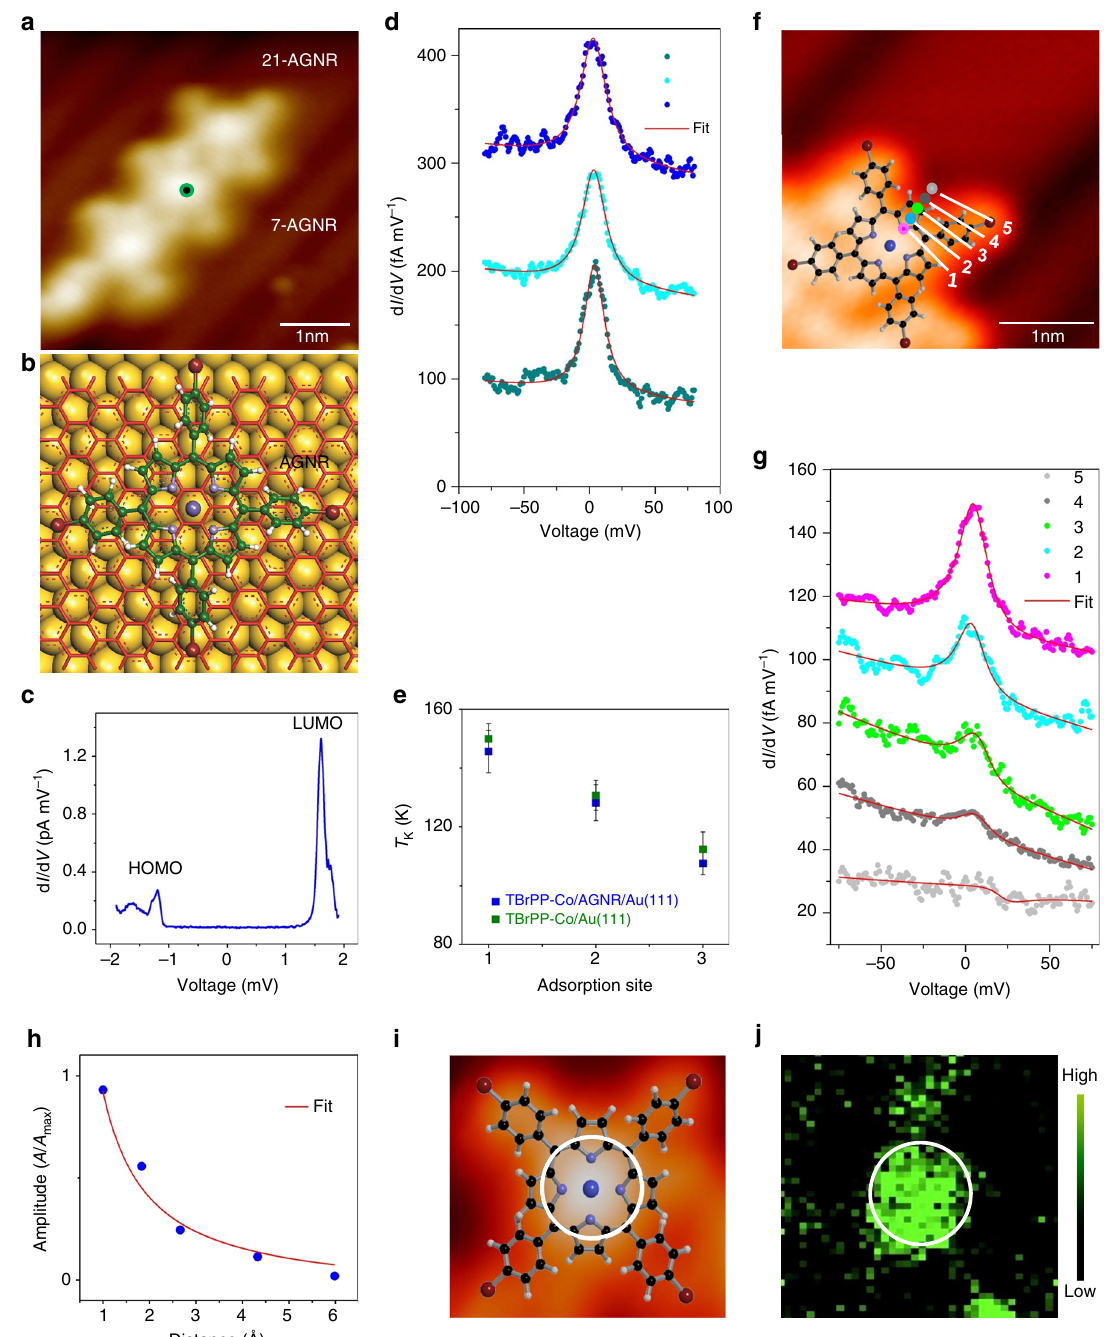
Fig. 3 Properties of TBrPP-Co/AGNR/Au(111). a STM image of TBrPP-Co on AGNR (4.5 × 4.5 nm 2 , I t = 3 × 10 − 12 A, V t = 1 V). b Adsorption site of TBrPP-Co on AGNR. c d I /d V – V spectroscopy of TBrPP-Co on AGNR/Au(111) shows a fl at bottom at the HOMO – LUMO gap (tip set-point: I 0 = 1.0 × 10 − 11 A, V 0 = 1.99 V). d High-resolution d I /d V spectra of TBrPP-Co on AGNR/Au(111) exhibit Kondo peaks with three different T K values ( q = 247, 250 and 250 for 1, 2 and 3, respectively. Tip set-point: I 0 = 1.0 × 10 − 11 A, V 0 = 0.2 V. Spectra are vertically offset by 100 fA/mV for clarity). e T K as functions of adsorption site 1, 2 and 3 (Fig. 2d – f) for TBrPP-Co on AGNR/Au(111) ( green ) and on Au(111) ( blue ). Error bars are determined from the standard deviations of the Kondo fi ts. f An STM image of TBrPP-Co at the end of a molecular cluster on AGNR (4.6 × 3.3 nm 2 , I t = 1 × 10 − 11 A, V t = 0.2 V). g A sequence of d I /d V spectra taken at the locations of coloured dots labelled 1 – 5 in f show decreasing Kondo amplitudes as the tip moves away from the molecule centre (tip set-point: I 0 = 1.0 × 10 − 11 A, V = 0.2 V. Spectra are vertically offset by 20 fA/mV for clarity). h The normalized Kondo amplitude ( A / A 0 max ) as a function of distance r from the molecule centre show r 1 dependence. i A zoom in STM image of a TBrPP-Co molecule (2.0 × 1.9 nm 2 , I t = 1 × 10 − 11 A, V t = 0.2 V) and corresponding d I /d V Kondo map j acquired at 7 mV energy [tip set-point: I 0 = 1.0 × 10 − 11 A, V 0 = 0.2 V). The central part of the molecule is circled in i , which appears as a higher intensity in